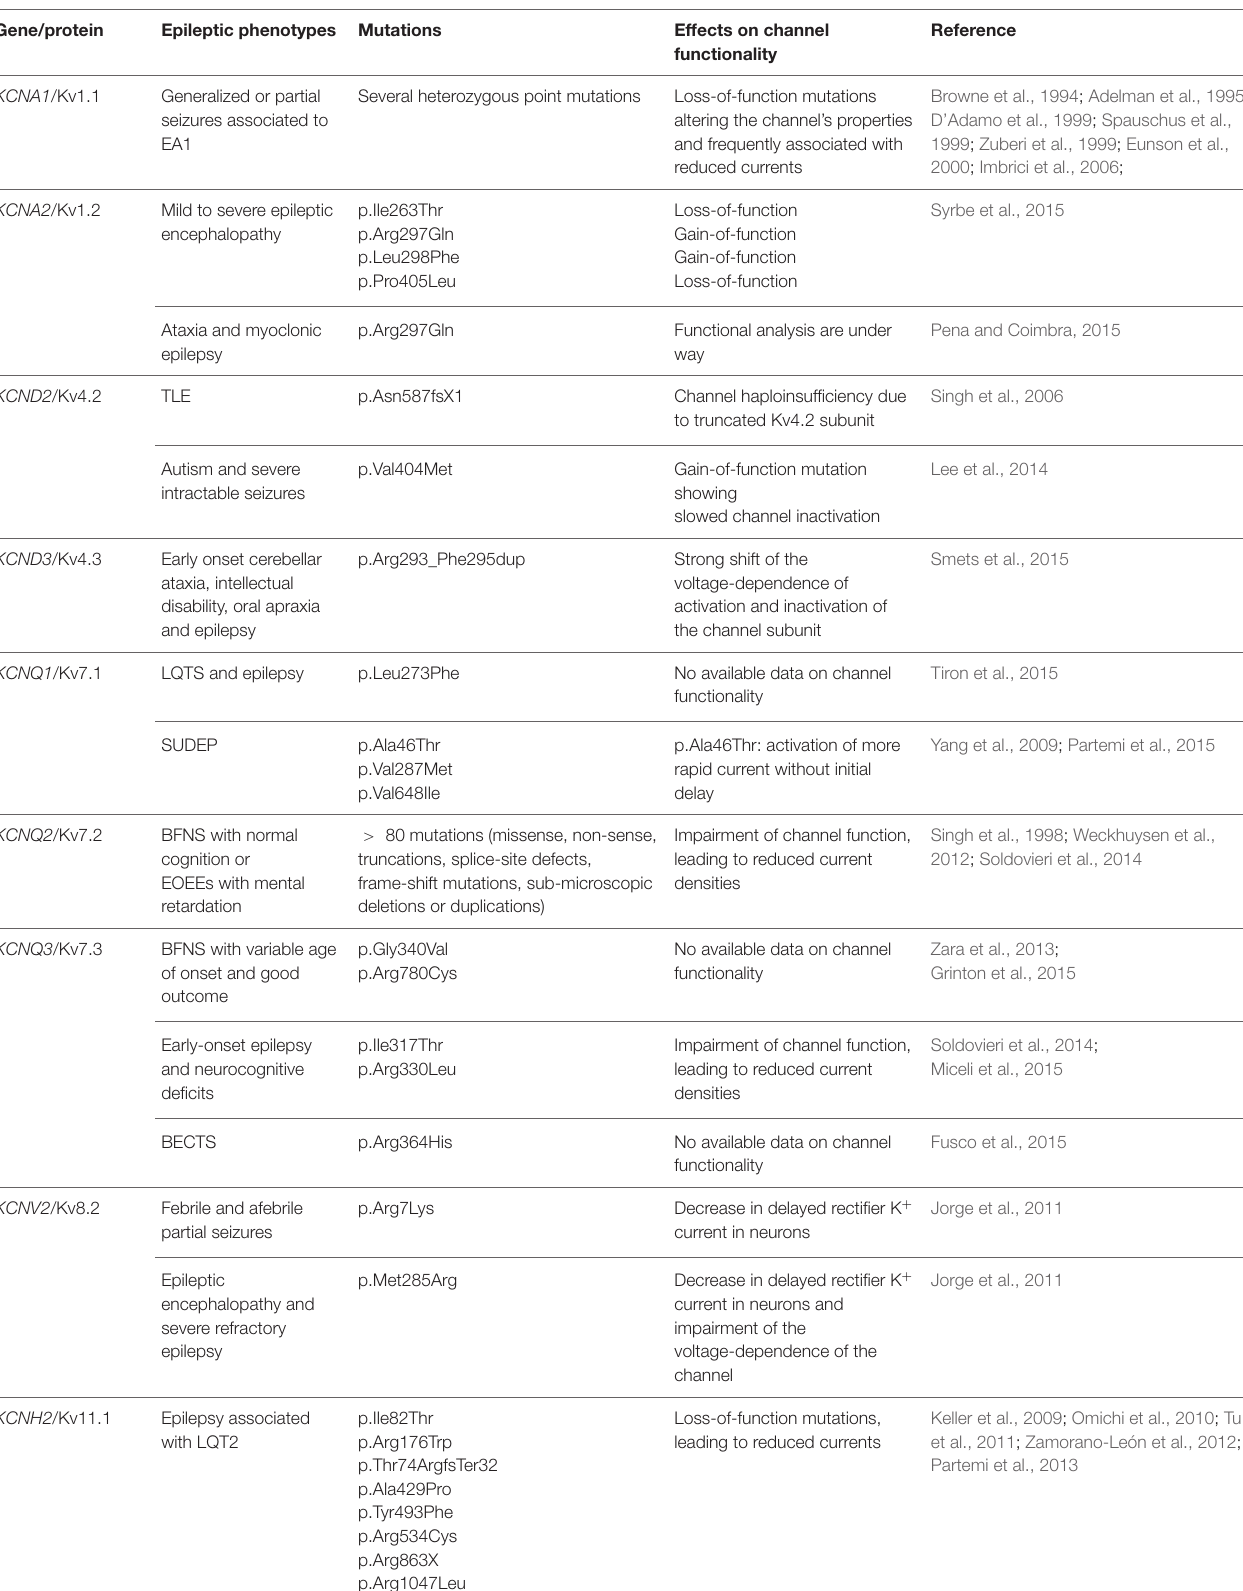
TABLE 2 | Mutations in K + channels associated with human epileptic